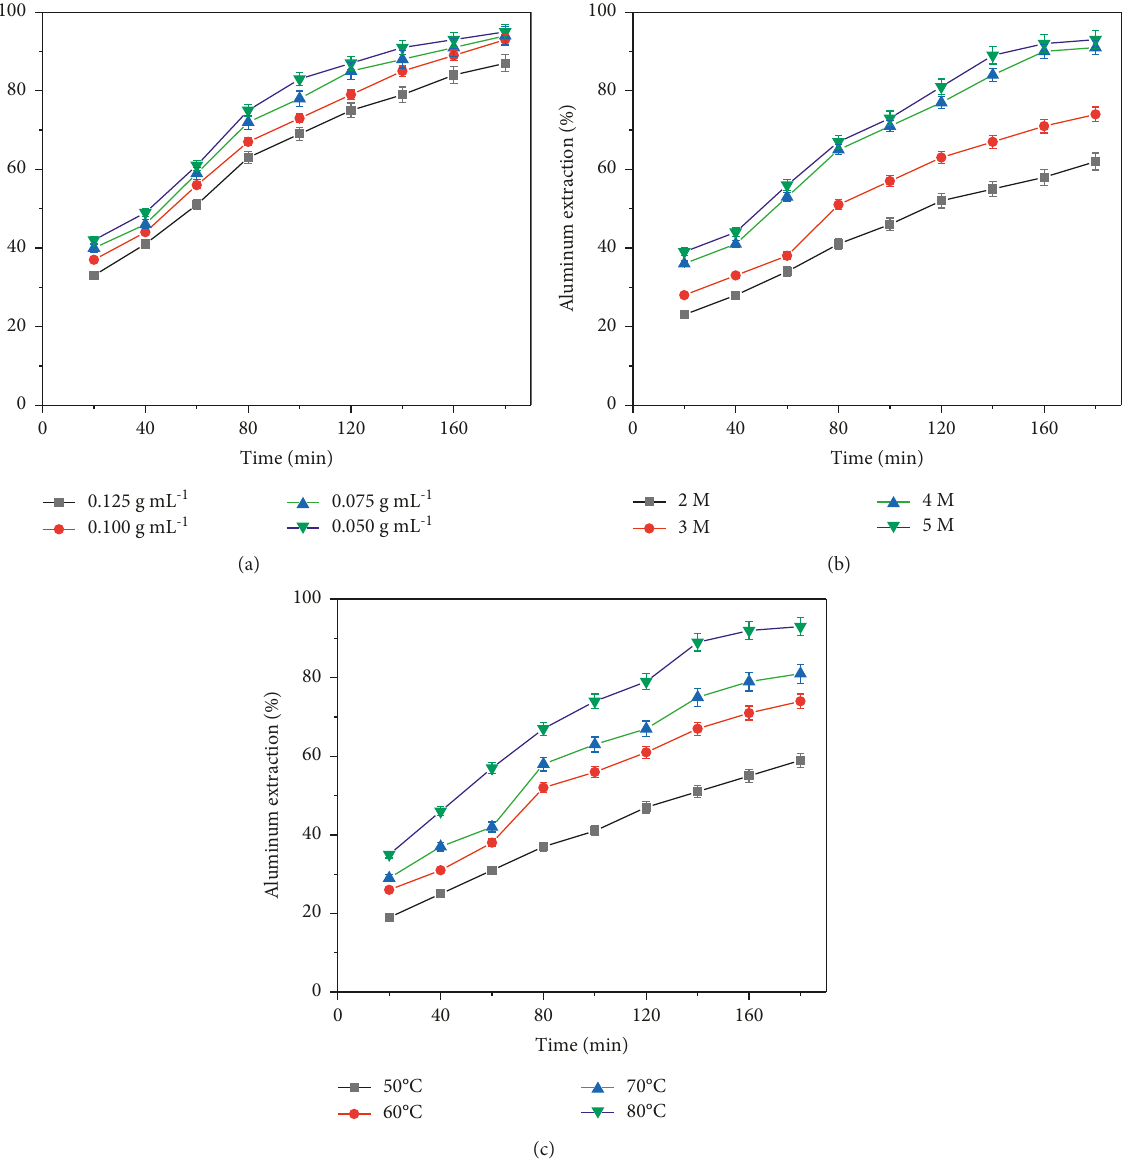
Figure 2: Effects of (a) solid-to-liquid ratio from 0.050 to 0.125g · mL − 1 at 5 M and 80 ° C, (b) acid concentration from 2 to 5M at 0.100g · mL − 1 and 80 ° C, and (c) reaction temperature from 50 to 80 ° C at 0.100g · mL − 1 and 5M on the extraction yield of